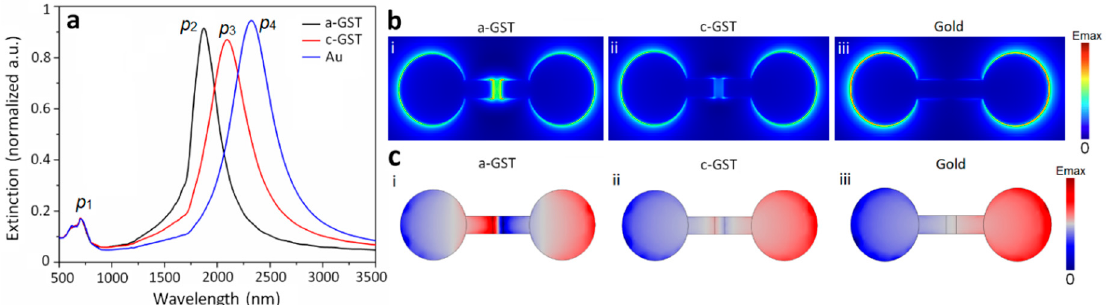
Figure 1. ( a ) General and ( b ) top-view schematics of a single unit cell. ( c ) ε 1 and ε 2 values for both GST phases (taken from Ref. 33).